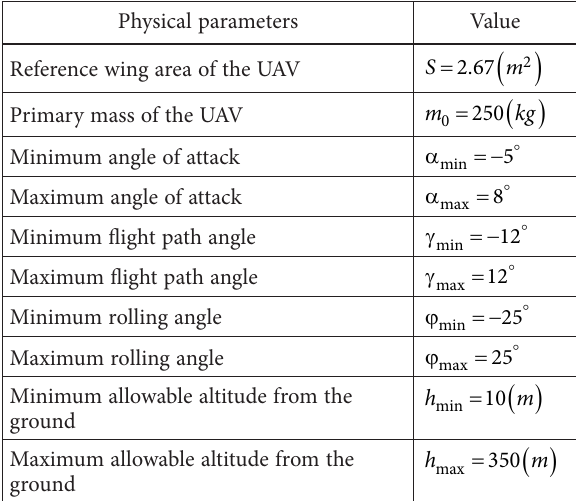
Table 2. Boundary conditions and constraints of the state variables obtained based on modeling the fractal